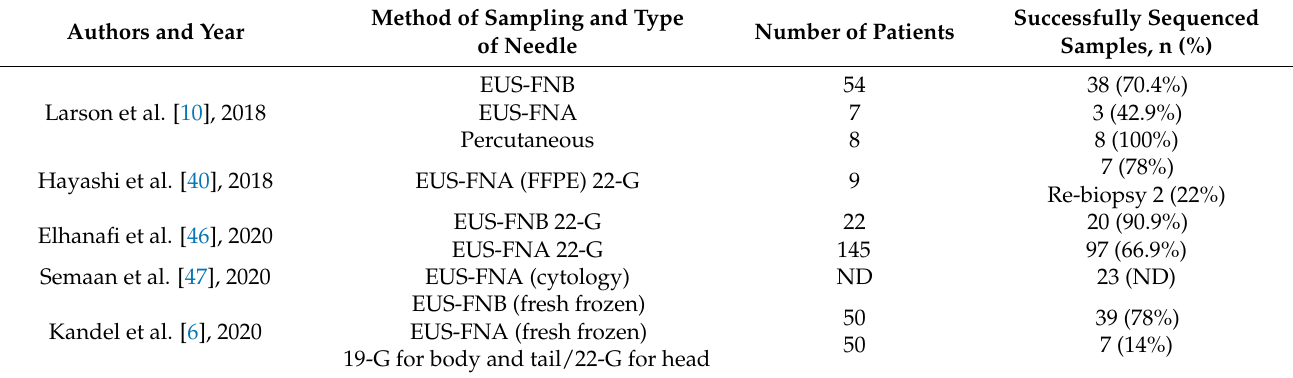
Table 1. Precision medicine for pancreatic ductal adenocarcinoma (PDAC) using endoscopic ultrasound (EUS)-guided sampling. Authors and